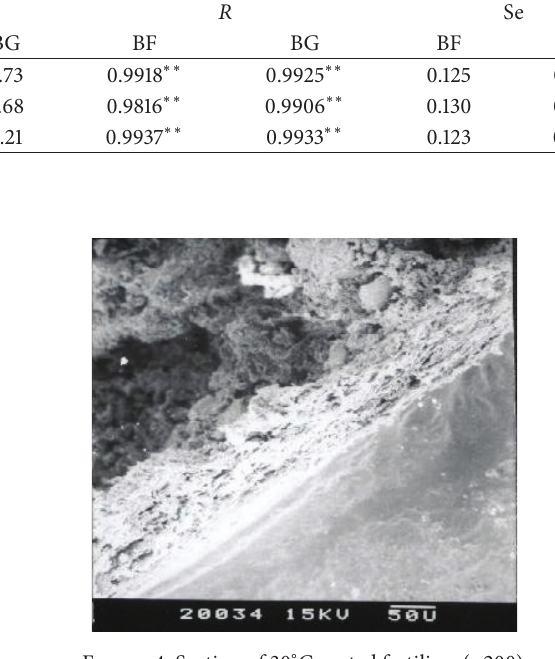
Figure 3: Section of 10 ∘ C coated fertiliser ( × 200). Figure 4: Section of 30 ∘ C coated fertiliser ( × 200).